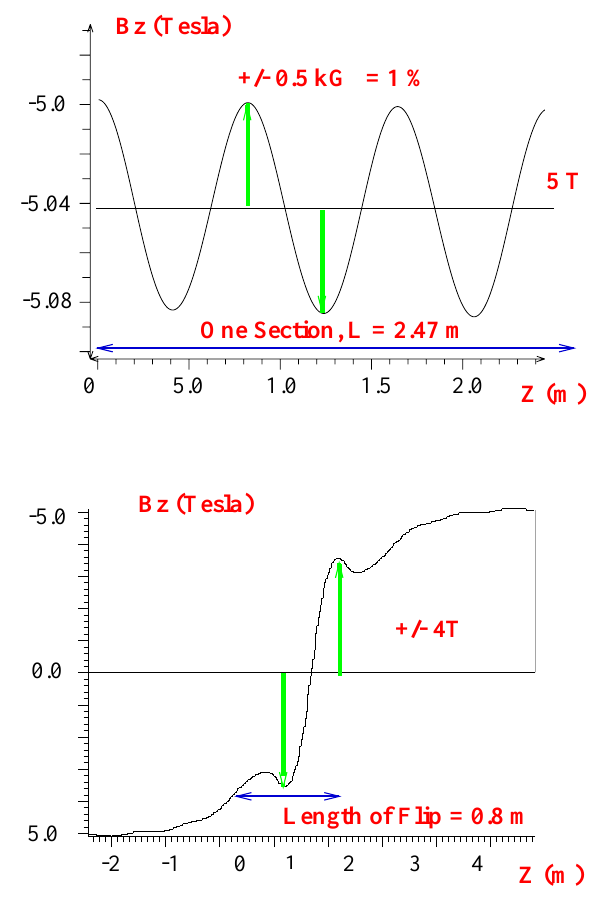
FIG. 7. (Color) Top: variation of the axial field Bz (kGauss) at r (cid:1) 0 cm in the single flip cooling channel, for the constant field stages. Bottom: variation of the axial field at r (cid:1) 0 in the matching (field flip)